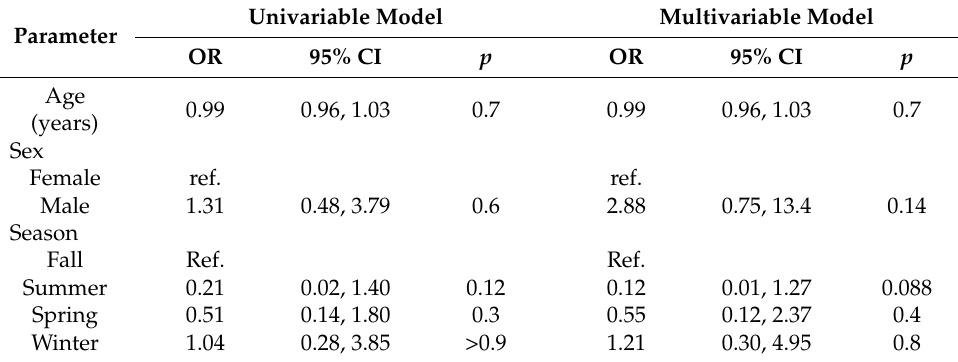
Table 3. Differences in curve normalization by baseline